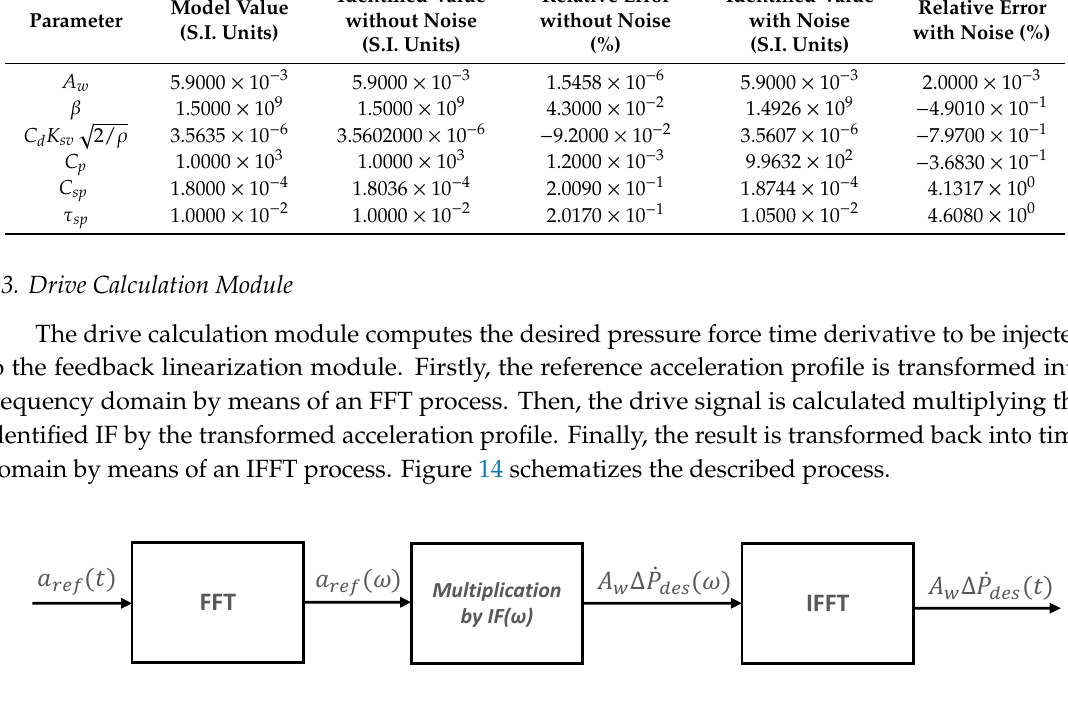
Figure 14. Drive calculation process.